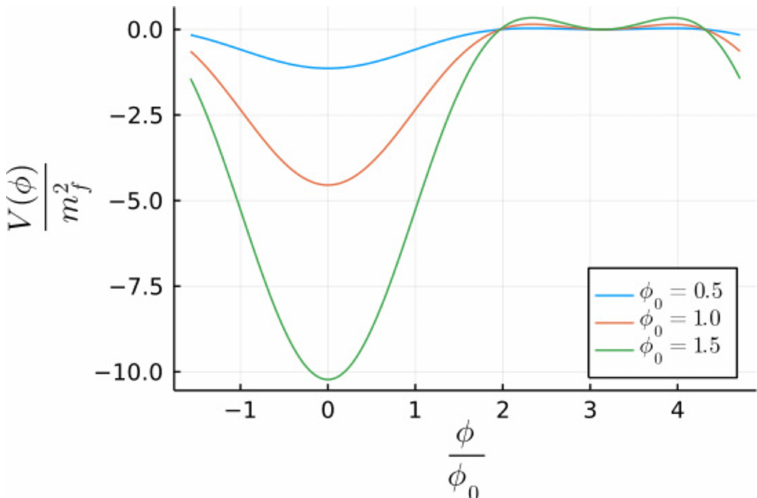
Figure 1 . The potential in (2.15) for different values φ 0